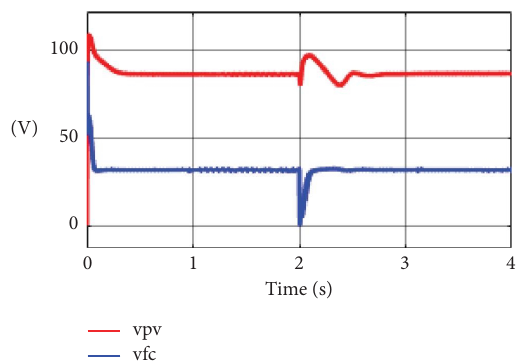
Figure 26: V PV and V FC in the third operation mode.